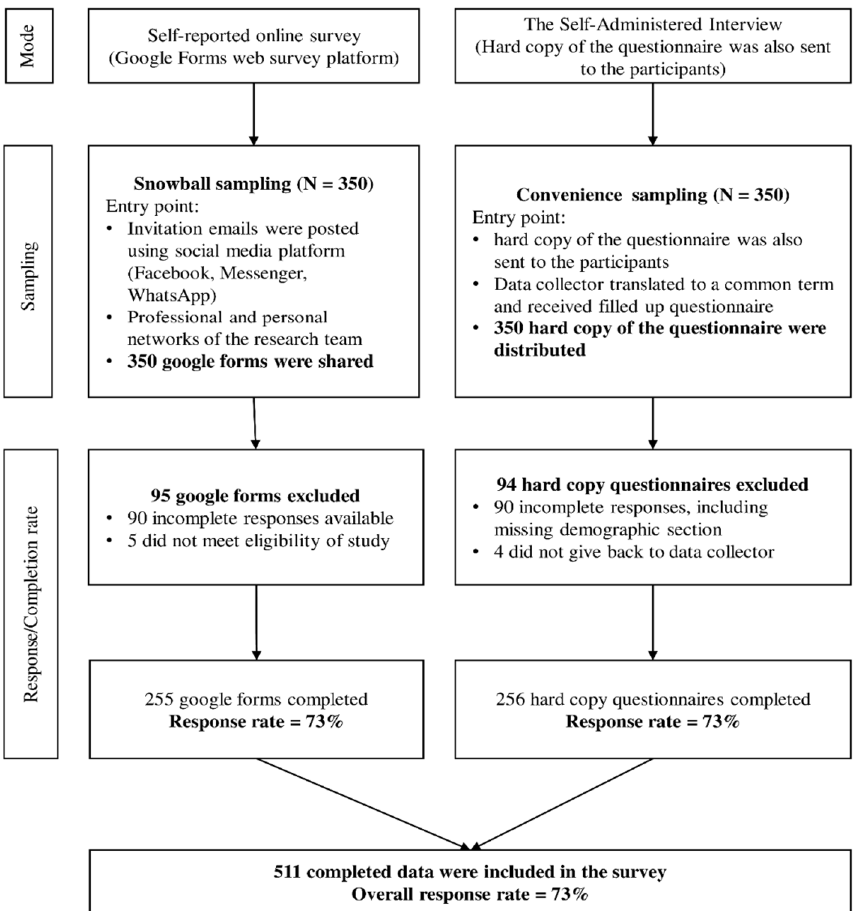
Figure 1. Flowchart depicting the data collection survey procedure using two sampling techniques.